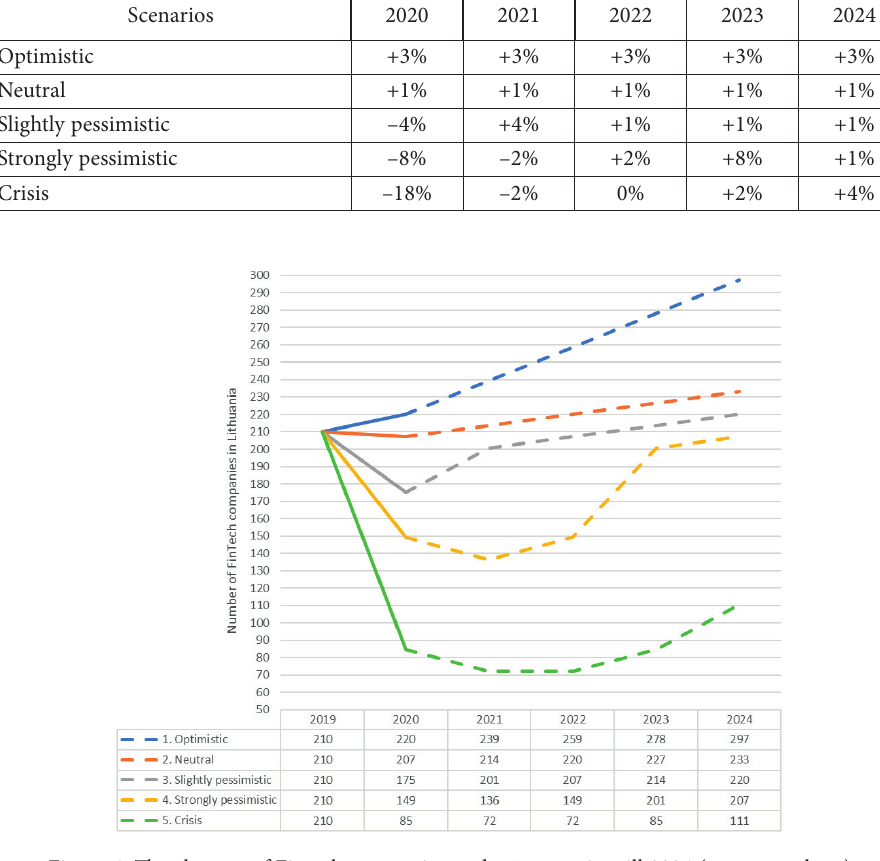
Figure 4. Th e changes of Fintech companies under 5 scenarios till 2024 (source: